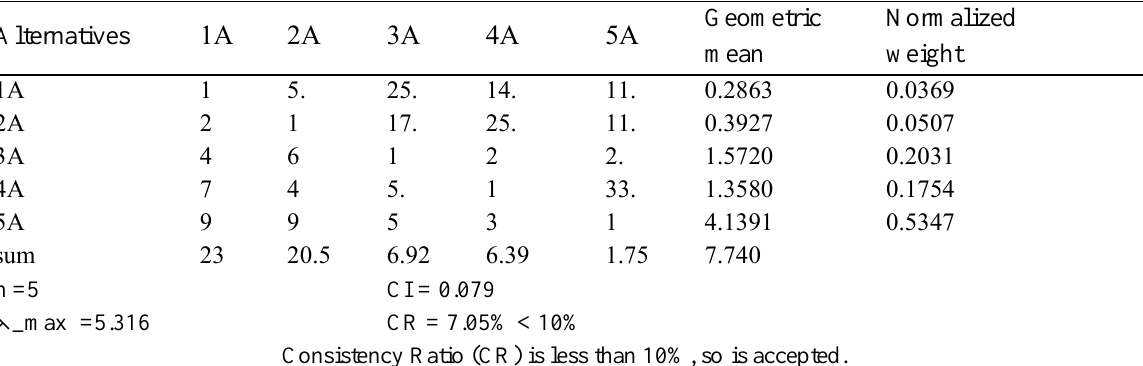
Table 13. Comparison Matrix of Alternatives with respect to